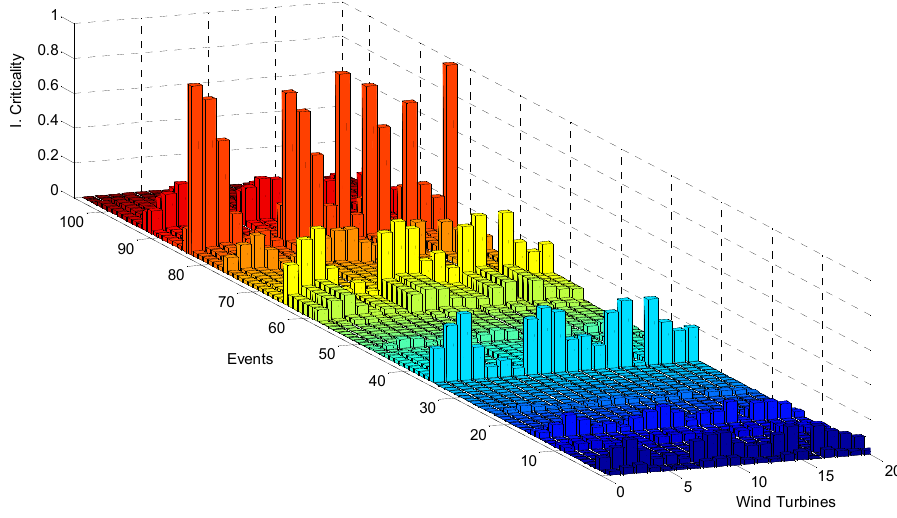
Figure 6. Criticality importance of the events in a given time.